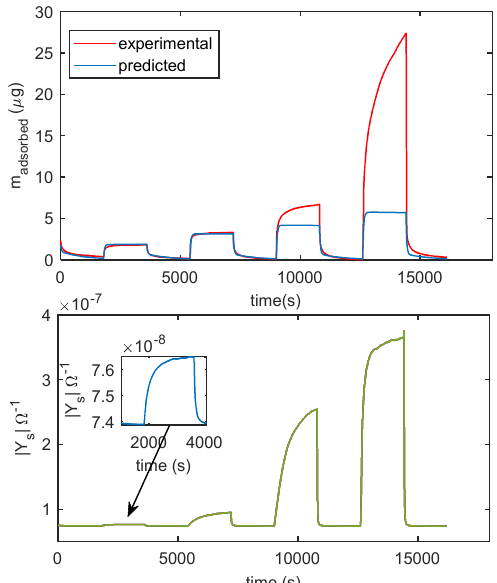
Figure 14. Comparison of measurements obtained with the cantilever sensor and with the impedance sensor. The measurement protocol is the same described in Figure 11b. Upper plot: measured adsorbed mass (red line), adsorbed mass predicted by the model of Equation (3) (blue line). Lower plot: magnitude of the admittance of the film measured at 100 Hz.